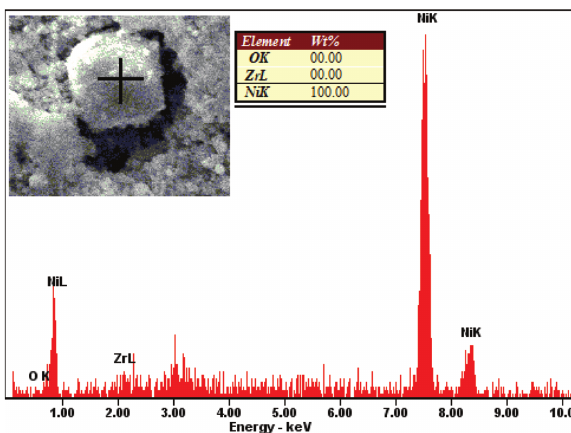
Figure 3: EDS spectra of large Ni grain observed in the NiO-YSZ layer sintered in vacuum at temperature of 1,200° С .